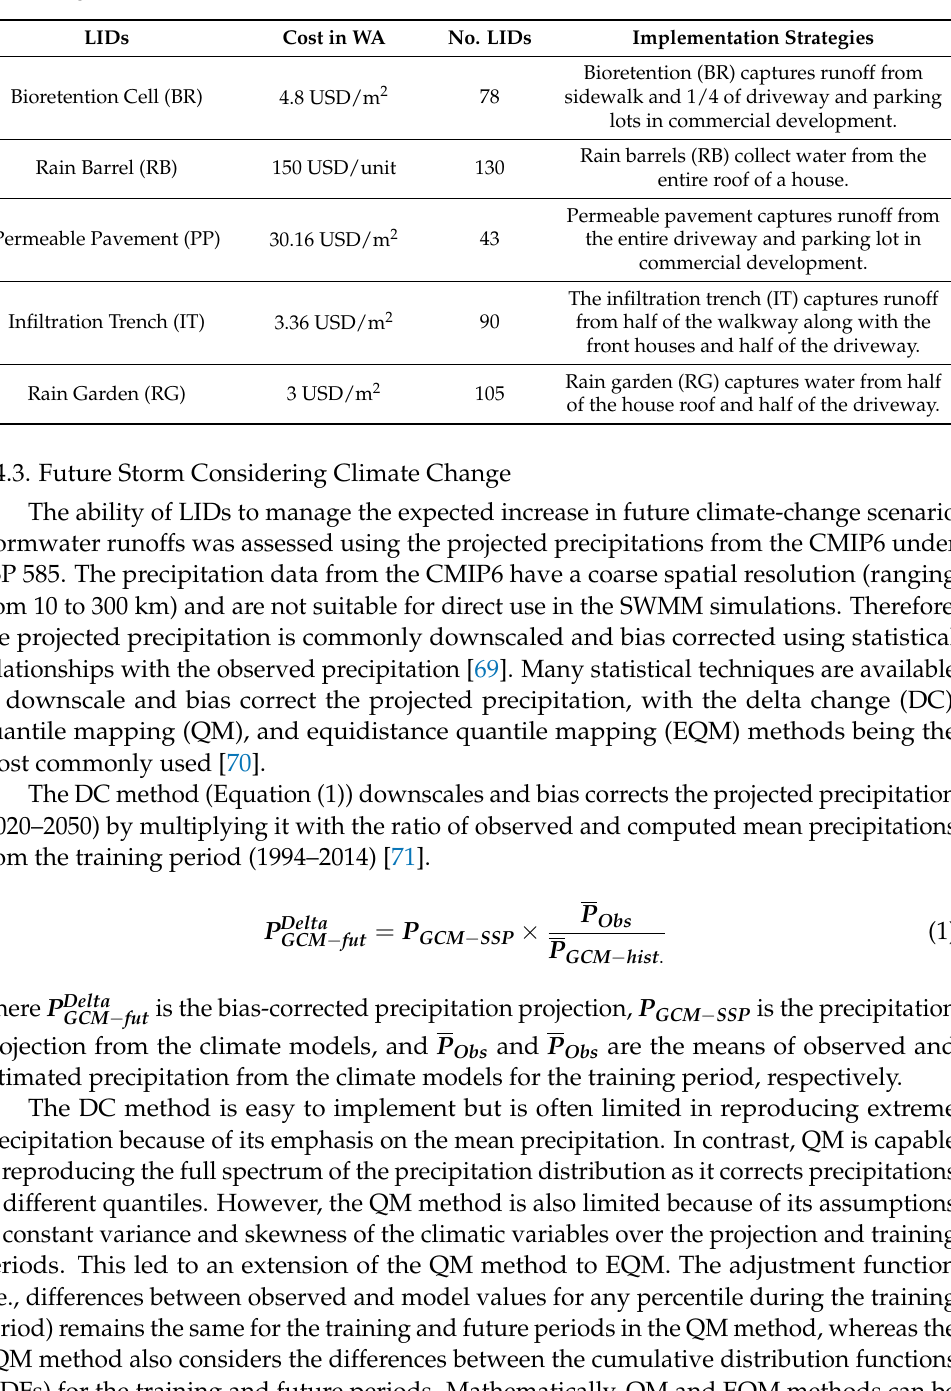
Table 2. The five existing LIDs considered in our study, their associated costs, sizes, and implementa- tion